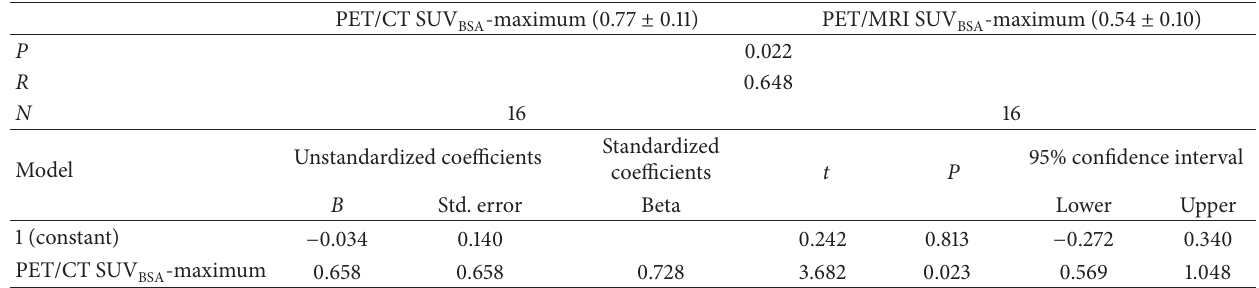
-maximum and PET/MRI SUV BSA